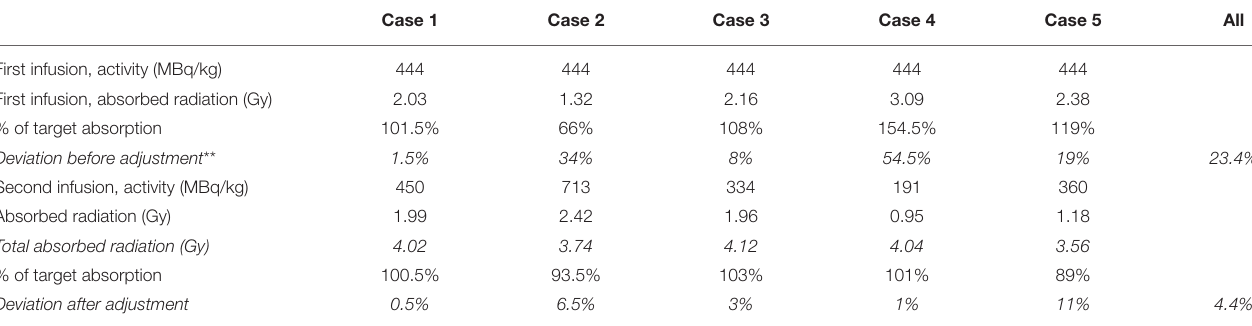
TABLE 3 | Dosimetry group—activity adjustment and dispersion